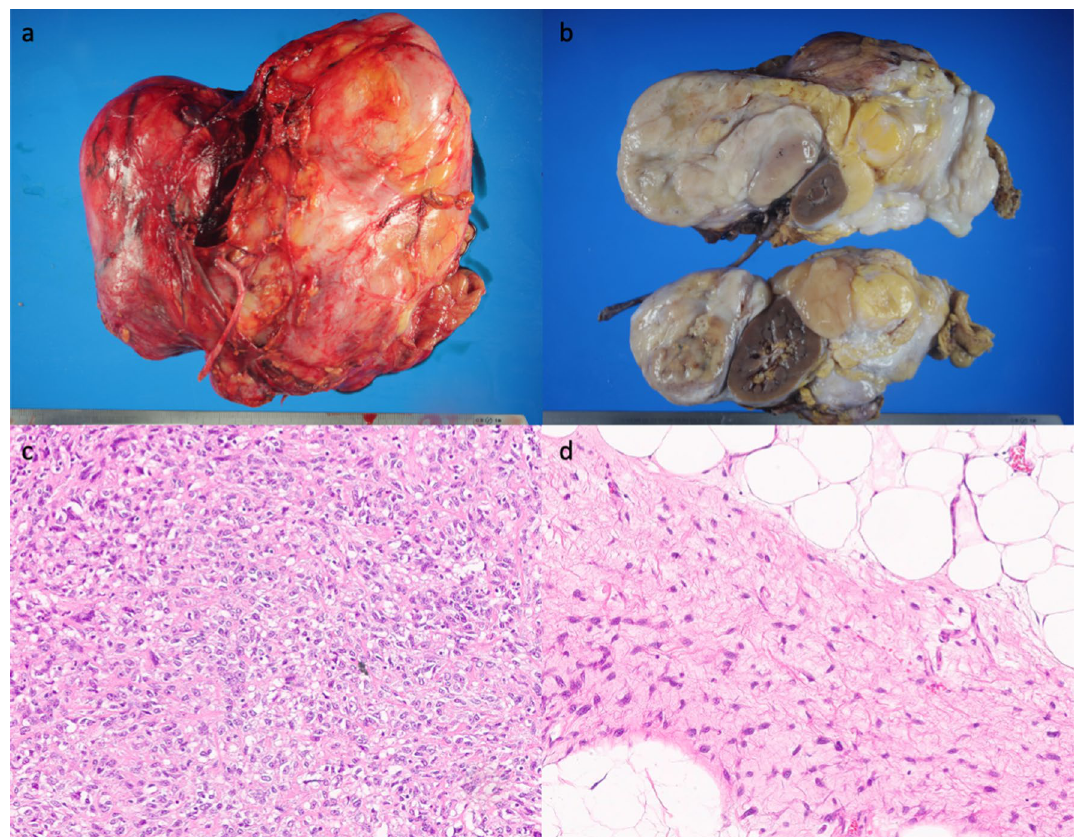
Fig. 3 Macroscopic and microscopic findings of the tumor. The excised specimen was a lobulated mass measuring 27 ( a ). The right kidney was surrounded by the tumor ( b ). Proliferation of atypical short spindle or oval cells resembling high grade undifferentiated sarcoma ( c ). The presence of a well differentiated liposarcoma component, showing mature-appearing adipose tissue and fibrous bands with irregular nuclei ( d